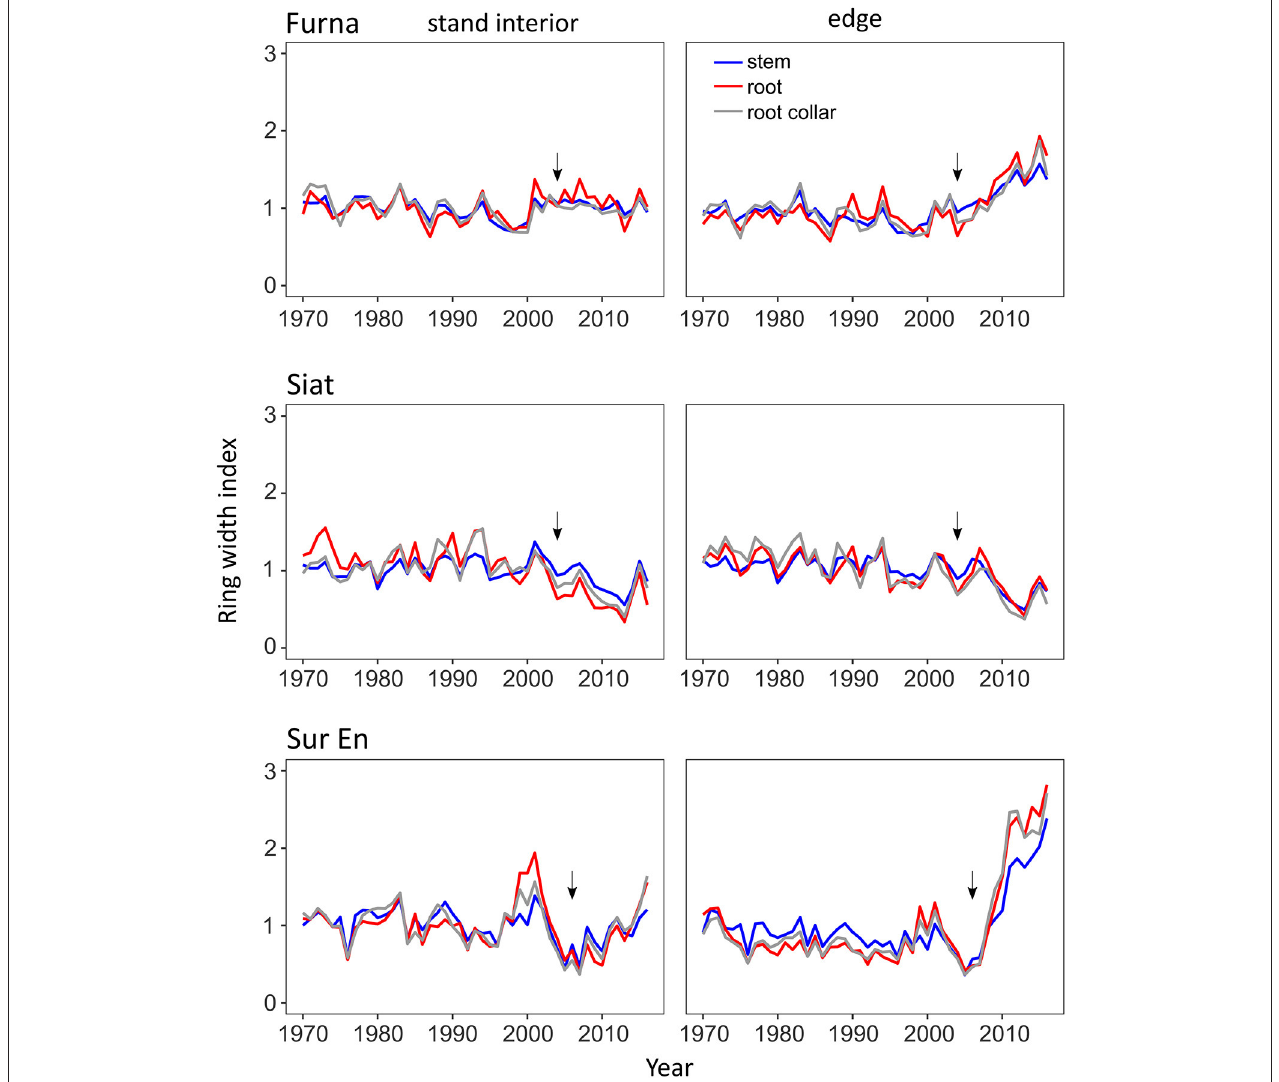
FIGURE 3 | Mean chronologies of the ring-width index for stand interior and edge trees in the three study sites Furna, Siat, and Sur En for the period 1970–2016. Arrows indicate the cutting year.